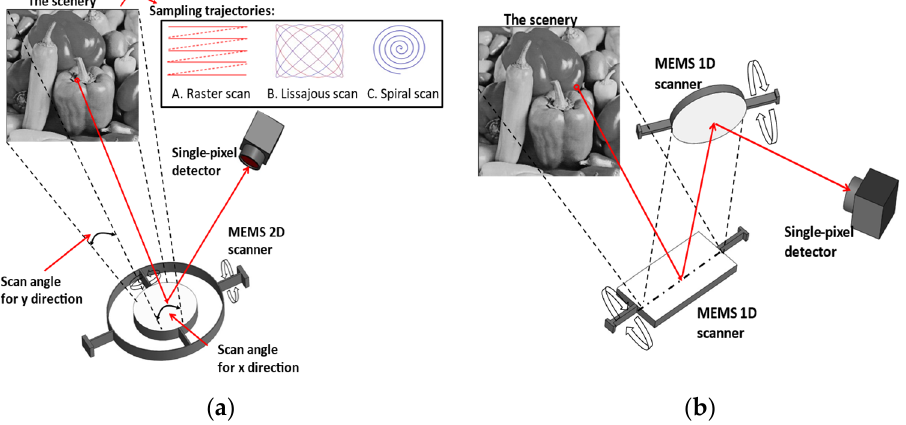
Figure 1. Schematic of two scanning strategies to build a single-pixel imaging system: ( a ) using a single dual-axis scanner; ( b ) using two orthogonal single-axis scanners.